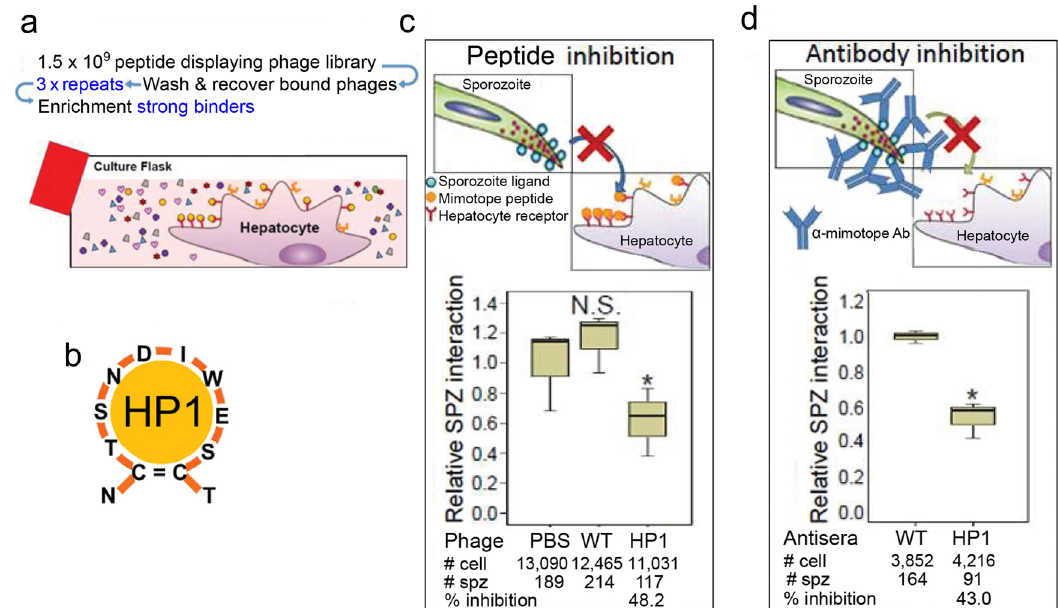
Fig. 1 The HP1 peptide mimics a sporozoite ligand. a Schematic diagram of the screen for peptides that have a strong af fi nity to primary mouse hepatocyte surface molecules. The phage display library has a complexity of 1.5×10 9 different peptides. b Amino acid sequence and the basic structure of the strongest hepatocyte binder, HP1 peptide. All library peptides have cysteine at positions 2 and 11 that form a disul fi de bond and give the peptide conformation. c Peptide that mimics the ligand conformation (mimotope) should bind to the hepatocyte receptor and by doing so, inhibit sporozoite – hepatocyte interactions (diagram in the upper panel). Primary mouse hepatocytes were incubated with an HP1 phage or a wild-type phage (non-recombinant; control) and then incubated with P. berghei sporozoites. PBS buffer-treated group (no phage) served as another control. Relative sporozoite – hepatocyte interaction was determined by counting the number of sporozoite-bound and -invaded cells/total hepatocyte number (lower panel). Data pooled from three biological replicates. * P = 0.05. NS is not signi fi cant. d An antibody that recognizes the mimotope should bind to the sporozoite ligand and by doing so, inhibit sporozoite – hepatocyte interactions (diagram in upper panel). P. berghei sporozoites were pre-incubated for 10min with sera from mice that were immunized with HP1 phages and then incubated with primary mouse hepatocytes. Relative sporozoite interaction was determined as described above using WT phage antiserum treatment as a control (lower panel). All box plots show medians, quartiles, minimum, and maximums within the bounds of 1.5 times the interquartile range. % inhibition was calculated using medians. Relative sporozoite interaction was determined by normalizing sporozoite counts compared to the median of the control group, PBS treated, and WT phage antisera treated. Data pooled from three biological replicates. # cell: total hepatocyte number counted; # spz: total sporozoite number counted. * P = 0.05. c and d Two tail P -value by Mann – Whitney U test. Source data are provided as a Source Data fi